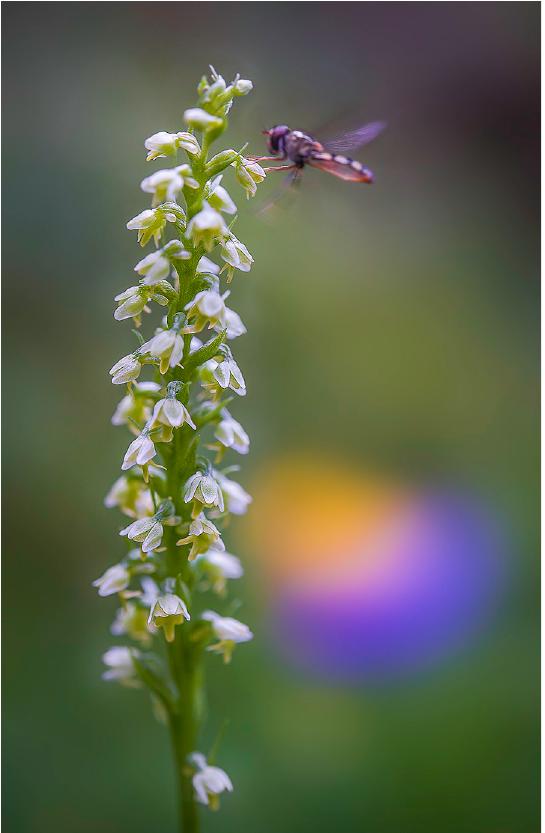
Fig 7. Pseudorchis albida (L.) A ´ .Lo¨ve & D.Lo¨ve subsp. tricuspis (Beck) E.Klein entire plant in its natural habitat (Fig 5), details of the inflorescences (Figs 6 and 7). One of the inflorescences (Fig 7) is visited by hoverfly of